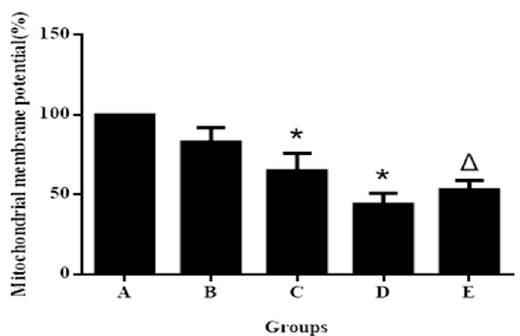
Figure 3. Mitochondrial membrane potential of hepatocytes exposed to aniline for 24 h. Data represented are mean ± SD of three identical experiments made in triplicate. A. 0 µ g/mL; B. 2.50 µ g/mL; C. 5.0 µ g/mL; D.10.0 µ g/mL; E. 10.0 µ g/mL + 20 mmol/L NAC. * Compared with control, p < 0.05; ∆ compared with 10.0 µ g/mL group, p < 0.05.